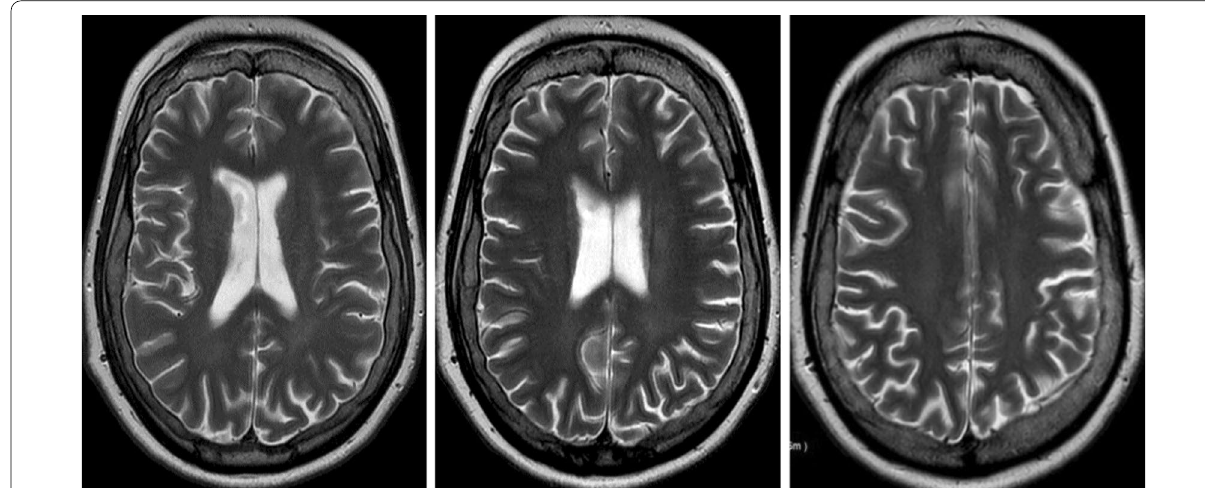
Fig. 1 Magnetic resonance axial sections T2 spin-echo sequence showing hyperintensities in the white matter